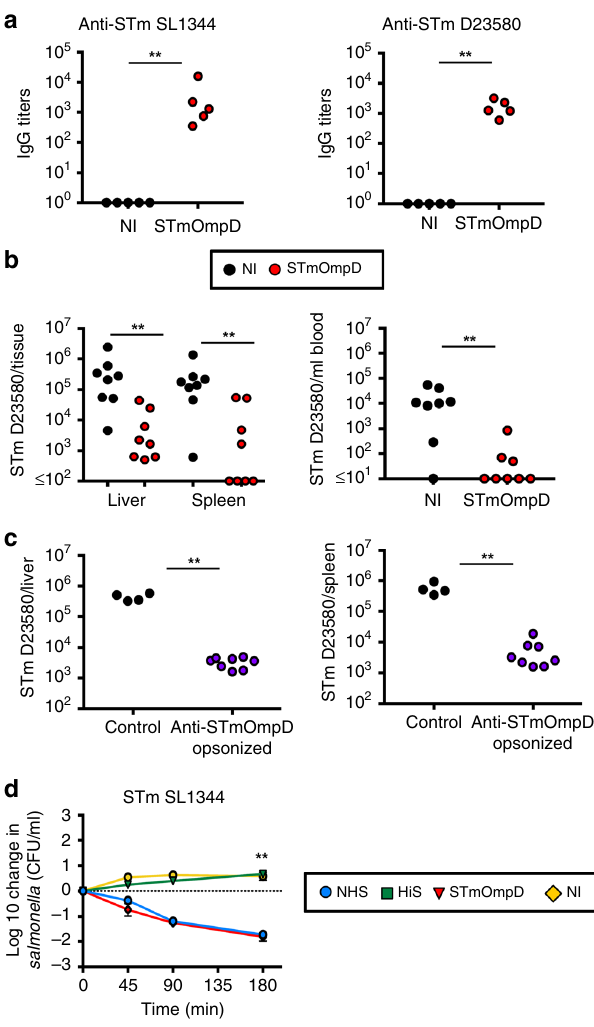
Fig. 1 STmOmpD induces antibody that can impair infection against STm. a WT mice were primed and boosted i.p. with 20 μ g of STmOmpD at days